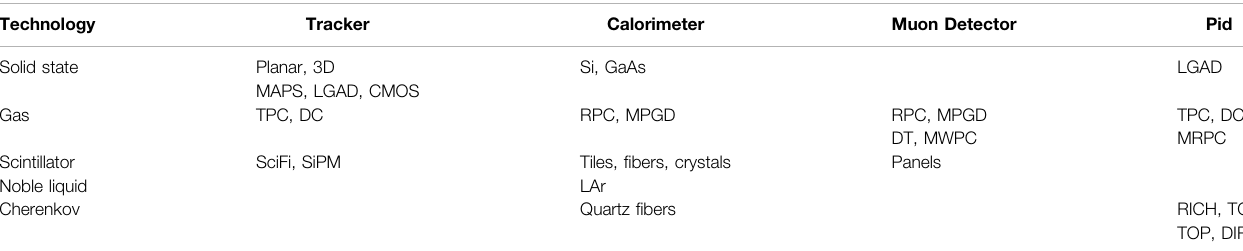
TABLE 2 | Summary of technologies and applications for future